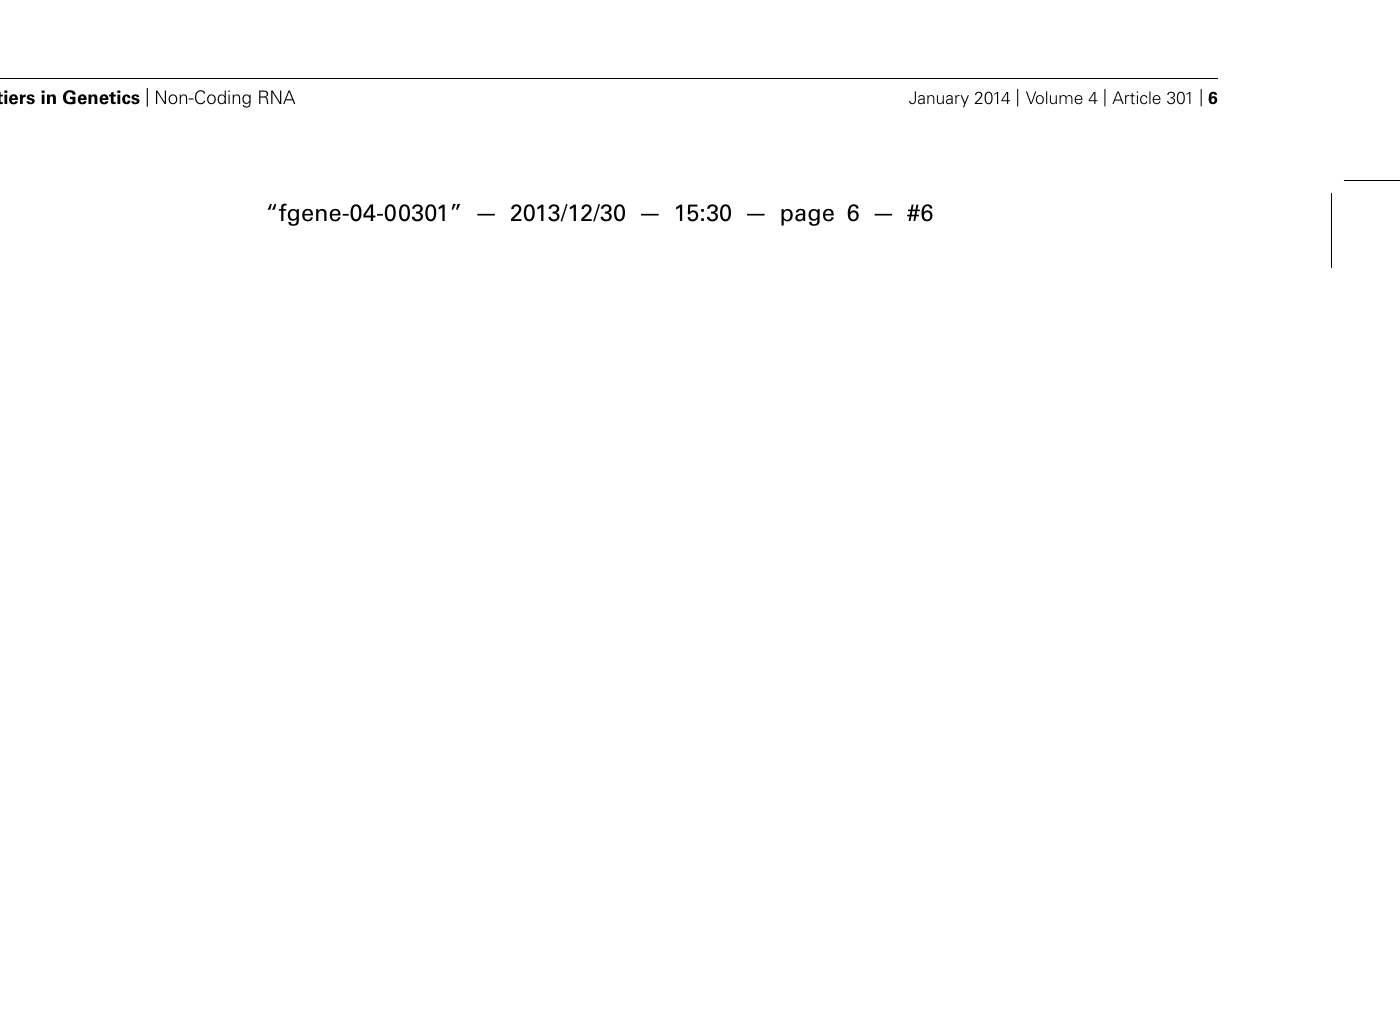
or mock control. (F) Confocal microscopy images showing the localization of transfected anti-miR21 (red). GFP is shown in green and Hoechst33342 in blue to indicate nuclei.The picture was taken by Zeiss LSM510 META 2-Photon microscope in Z-mode. Scale bars, 20 μ m.